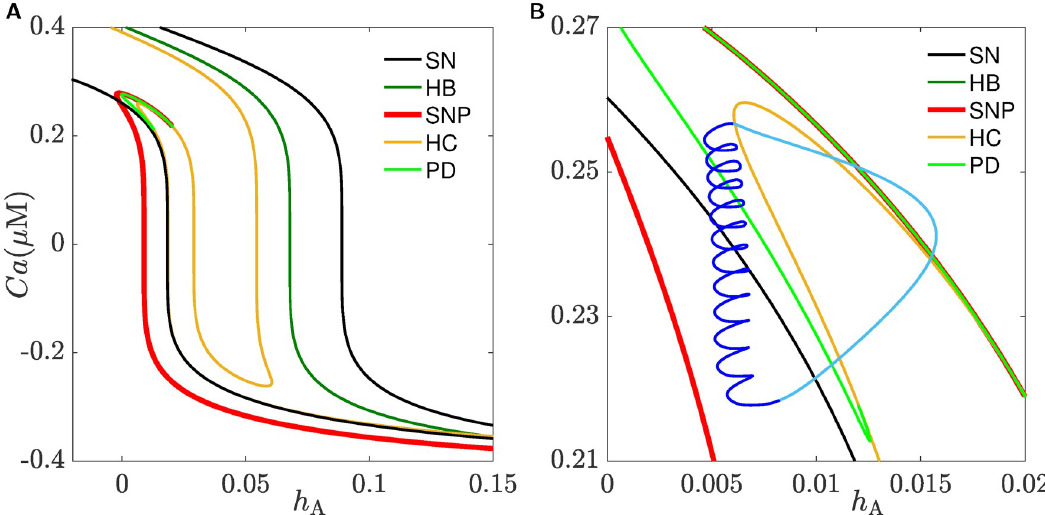
Fig 12. Two-parameter continuation of the bifurcation points in Fig 10. A ) Two-parameter continuation of the bifurcation points SN 1 , SN 2 , HB , SNP , HC 1 , HC 2 and HC 3 of the fast subsystem detected in Fig 10 plotted in the h A , Ca -plane. B ) The burst cycle (blue) is superimposed on an enlargement of the figure in A ; the arrows indicate the direction of flow and dark and light shades of blue distinguish between active and silent phases of the square-wave BPO, respectively. The curves produced by the bifurcation points are color-coded according to the legend in each